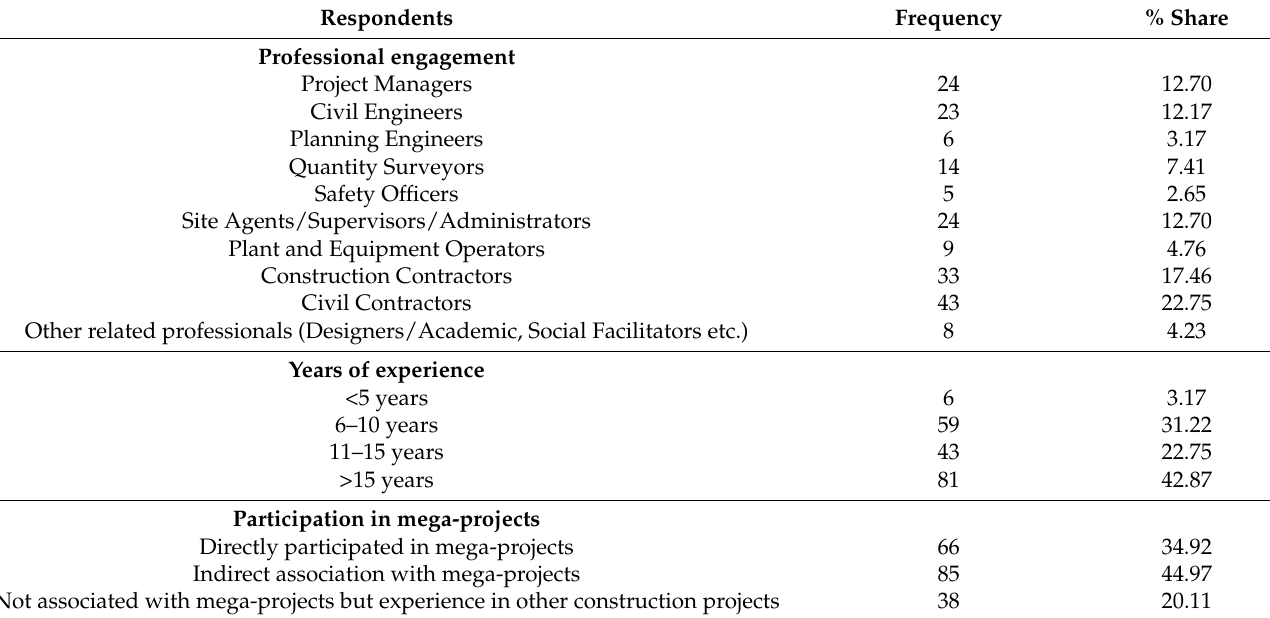
Table 1. Profile of the